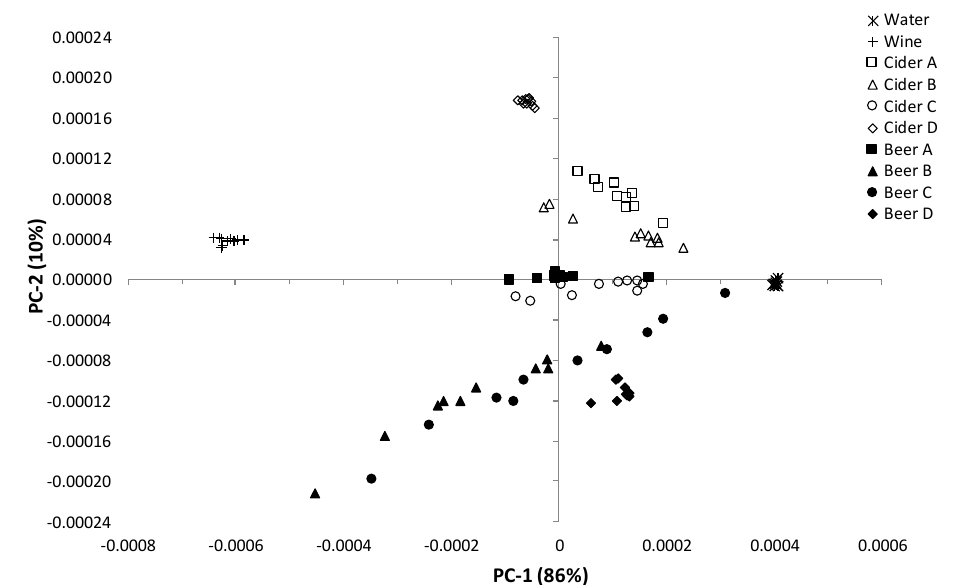
Figure 4. Score plot of the first two PCs derived from the MIR fingerprint region (1500–900 cm − 1 ) of beers and ciders, following long ‐ term (6 week) freezing.